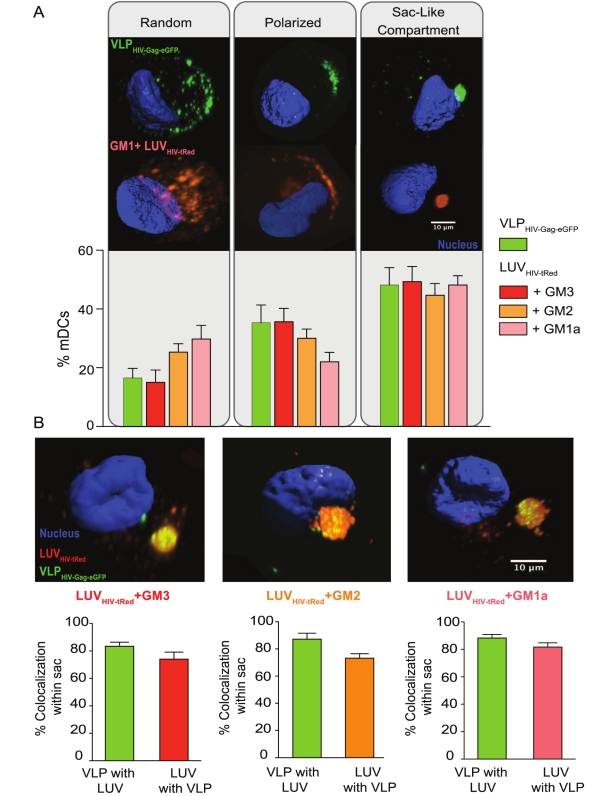
Ganglioside-containing LUVHIV-tRed traffic to the same compartment as VLP HIV-Gag-eGFP in mDCs.(A) (Top) Fluorescence images showing the different patterns of 75 ng of VLPHIV-Gag-eGFP Gag and 100 µM of GM1a-containing LUVHIV-tRed capture mediated by mDCs: random binding, polarized accumulation, and formation of a sac-like compartment. 3-D reconstructions of the x-y sections were performed collecting images every 0.1 µm throughout the whole mDC volume. Isosurface representation of DAPI-stained nucleus is shown, computing the maximum intensity of the green and red fluorescence within a 3-D volumetric x-y-z data field. (Bottom) Percentage of mDCs with distinct capture patterns after 4 h of independent challenging with VLPHIV-Gag-eGFP or ganglioside-containing LUVHIV-tRed. Cells were classified using confocal microscopy displaying particles as indicated in the top images. Data show mean values and SEM of more than 100 cells from five different donors. (B) Confocal microscopy analysis of mDCs previously pulsed with 100 µM of GM1a, GM2, and GM3 containing LUVHIV-tRed and then exposed to 75 ng of VLPHIV-Gag-eGFP Gag. (Top images) 3-D reconstructions of the x-y sections collected throughout the whole mDC z volume every 0.1 µm. Isosurface representation of DAPI stained nucleus is shown, computing the maximum intensity fluorescence of the sac-like compartment surface within a 3-D volumetric x-y-z data field, where VLPHIV-Gag-eGFP and ganglioside-containing LUVHIV-tRed are accumulated within the same compartment. (Bottom graphs) Quantification of the percentage of VLPHIV-Gag-eGFP co-localizing with ganglioside-containing LUVHIV-tRed and vice versa, obtained analyzing at least ten compartments from mDCs of three different donors. The mean and standard deviation of the thresholded correlation coefficients of Manders and Pearson (obtained considering all the images) were 0.752±0.03 and 0.44±0.11, respectively, indicating co-localization.